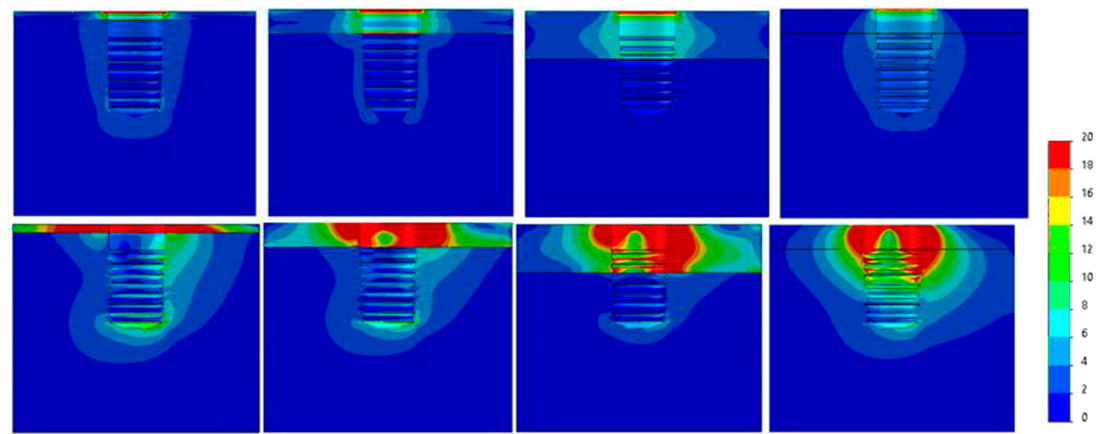
Figure 7. Von Mises equivalent stress (MPa) for Ø3.3 implant cases. Above, axial load, below, angled load. From left to right, Type IV, III, II, 0-I bone.